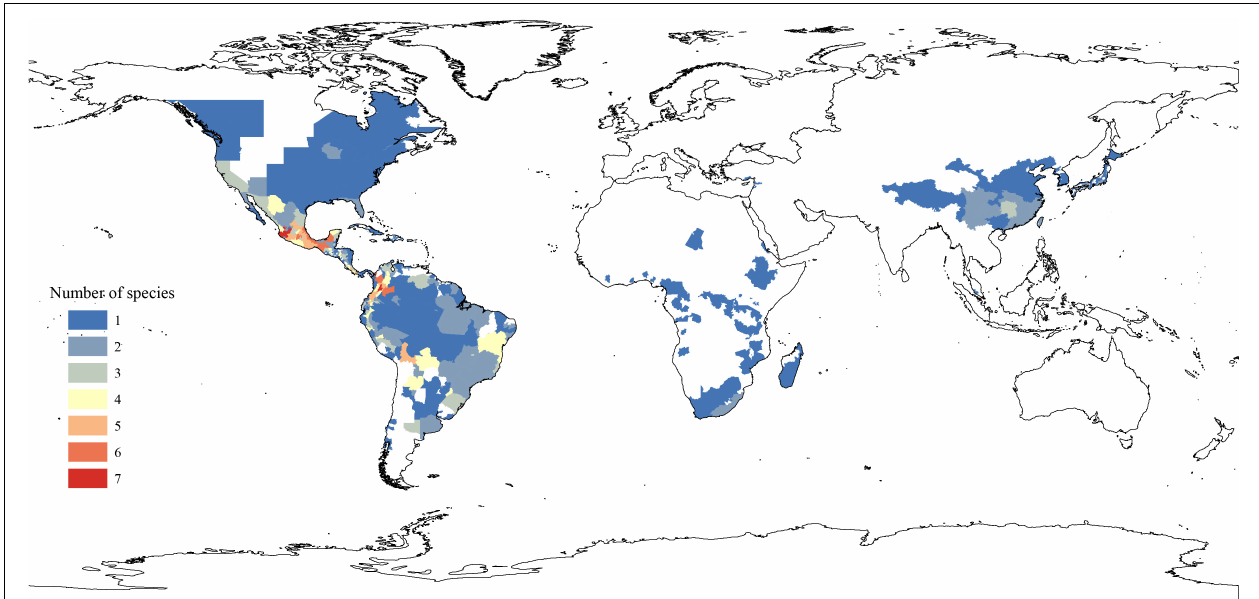
FIGURE 4 | Spatial patterns of Phytolacca species